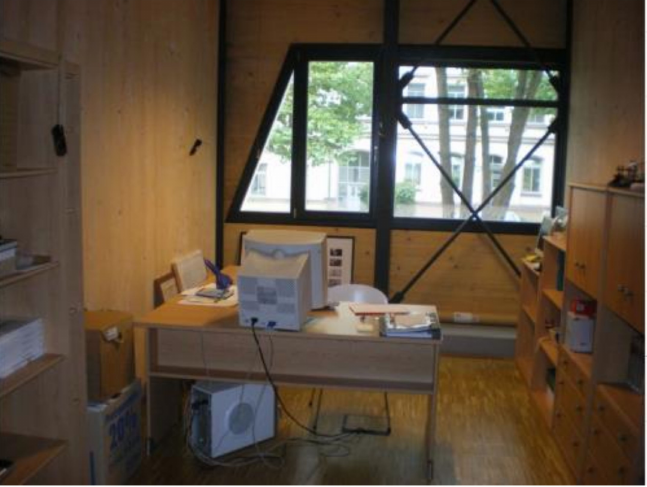
Figure 3. Office room (Supplementary Materials).